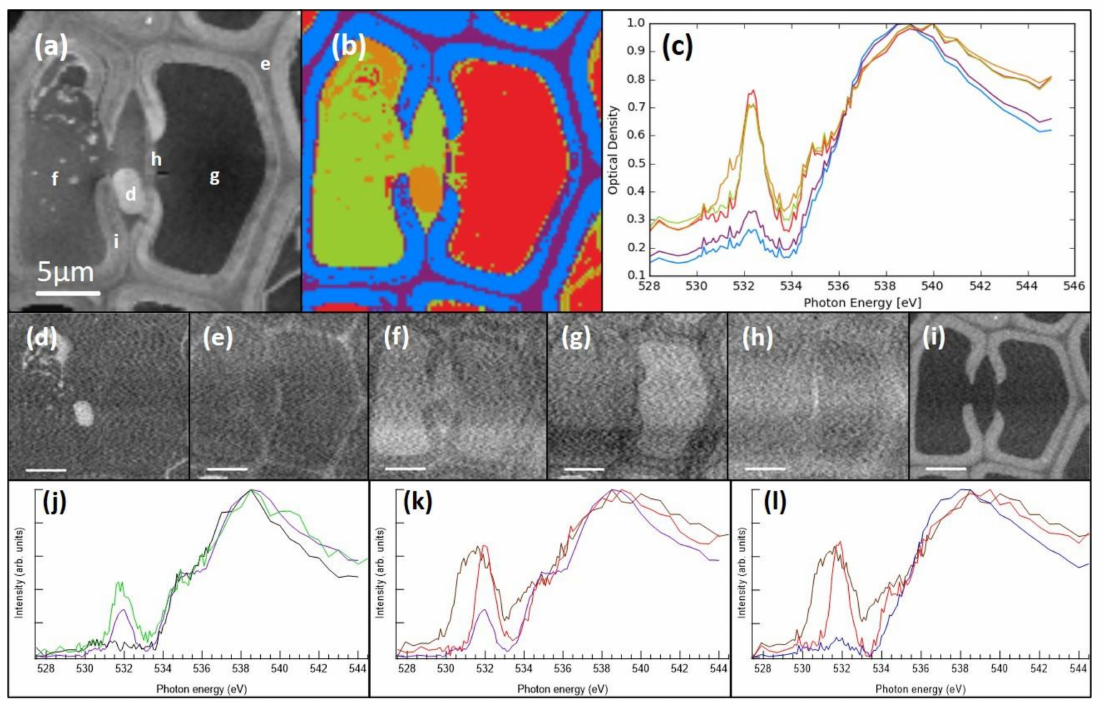
Figure 5. Cell structures of the resin-embedded knotwood tracheids with some deposit material measured on O 1s. ( a ) Average optical density map of STXM measurement with measurement locations for the structural spectra ( d – i ), ( b ) cluster analysis of the STXM measurement, ( c ) average cluster spectra of the cluster analysis. Localisations of ( d ) the measured deposit in the bordered pit chamber, ( e ) cell corner and compound middle lamella, ( f ) left tracheid, ( g ) right tracheid, ( h ) torus and ( i )secondarycellwallspectra. ( j )Spectraoftheepoxy-resin-subtractedlefttracheid(green), thereference lignan HMR (purple) and the tissue culture lignin (black). ( k ) Spectra of the epoxy-resin-subtracted deposit material (brown), the reference epoxy resin (red) and the HMR (purple). ( l ) Spectra of the epoxy-resin-subtracted deposit material (brown), the epoxy resin from the tracheid g (red) and the secondary cell wall (blue). Scale bars in all images are 5 µ